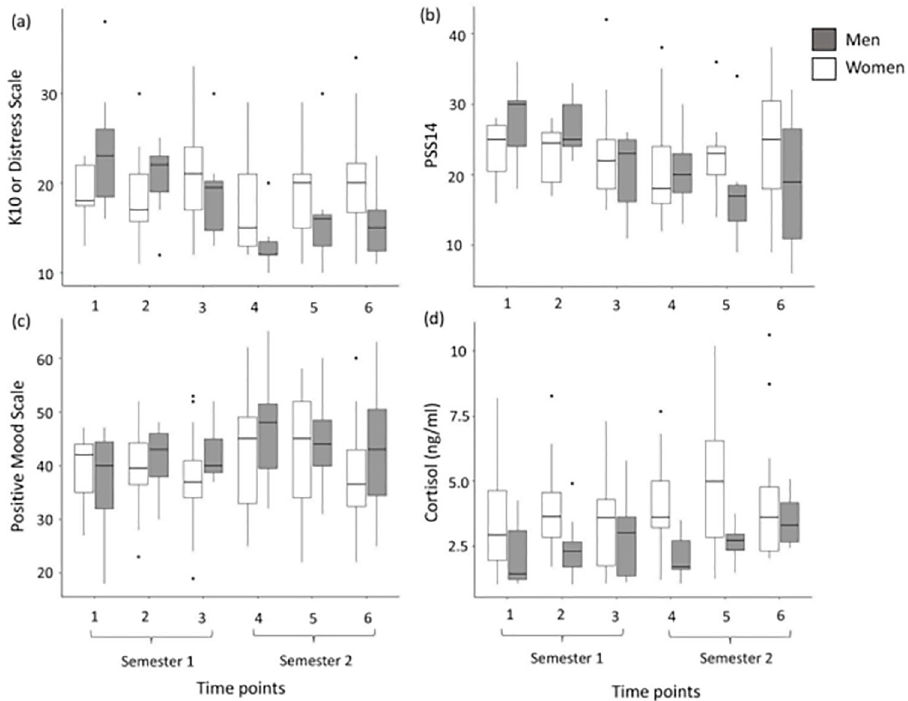
Fig 1. Psychological measures and physiological measures. (a) K10 Distress scale, (b) PSS14, (c) Positive mood scale and physiological measures of (d) Cortisol levels across six time points in the academic year. Grey and white boxes represent responses of men and women respectively. Boxplots show medians, quartiles, 5 th and 95 th percentiles and extreme values.